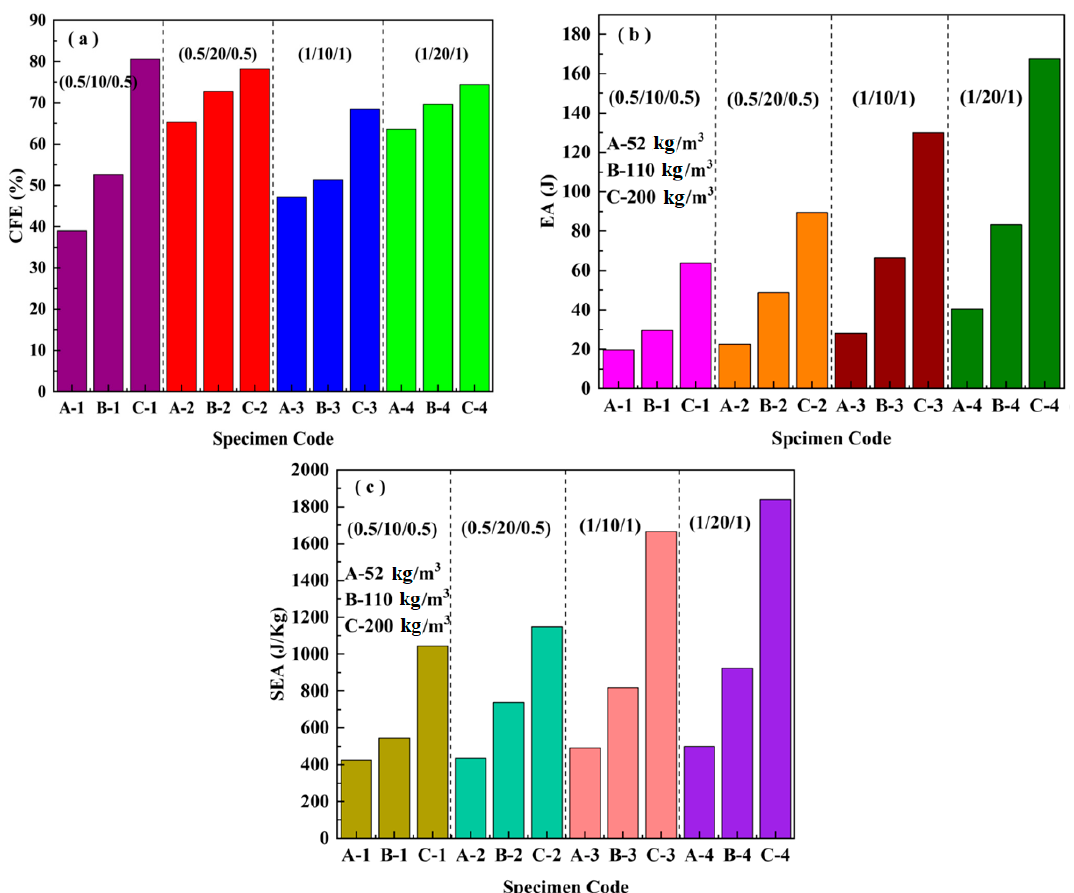
Figure 4. Effects of the density and thickness of the core and face sheet on: ( a ) crush force efficiency; ( b ) energy absorption; ( c ) specific energy absorption.